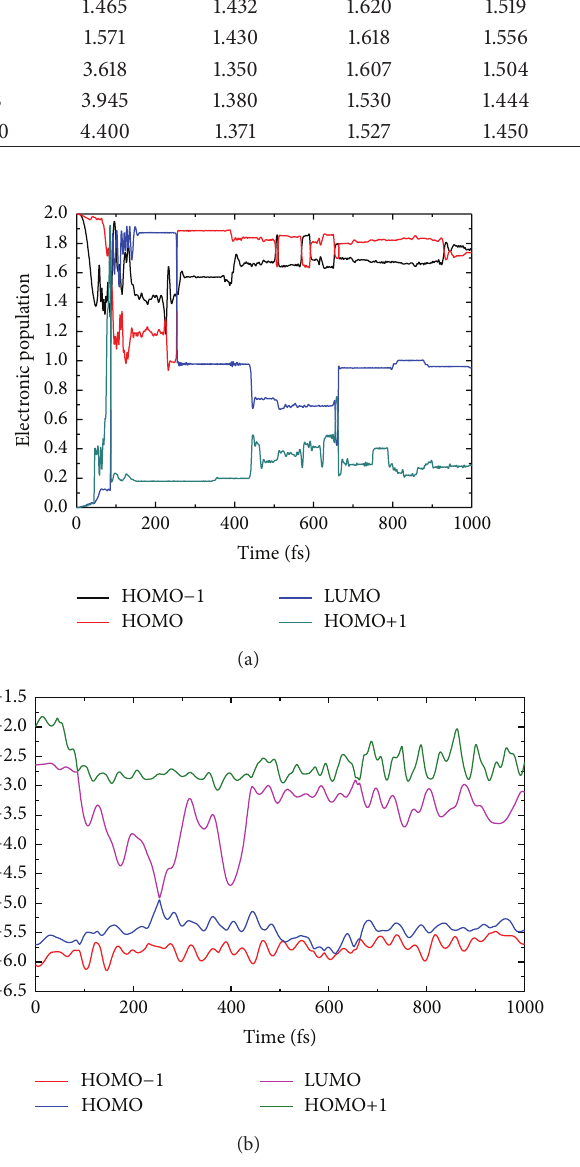
Figure 3: Variations with time of (a) the electronic populations and (b)energiesoftheHOMO − 1,HOMO,LUMO,andLUMO+1orbitals of cis-SP following application of a 80 fs (FWHM) laser pulse with a fluence of 0.188 kJ/m 2 and photon energy of 4.054